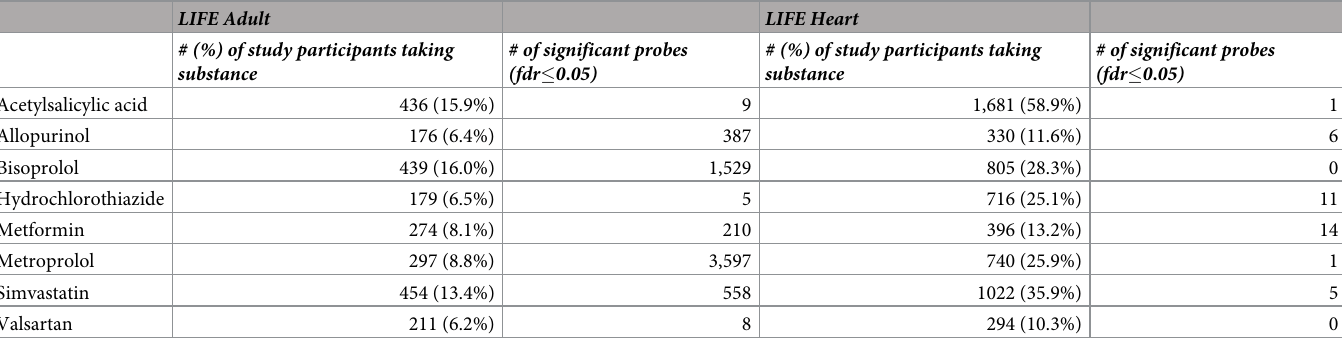
Table 2. Active substances showing significant effects on gene expression levels in LIFE-Adult and hence adjusted for in gene expression analysis. LIFE Adult LIFE Heart # (%) of study participants taking # of significant probes substance (fdr � 0 . 05)